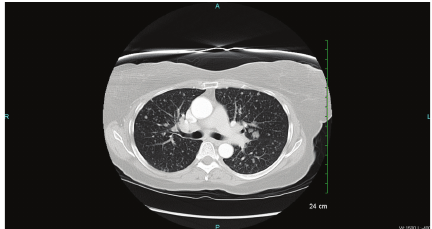
Figure 4: Chest CT scan showing multiple diffuse noncalcified nodules in both lung fields consistent with metastases.